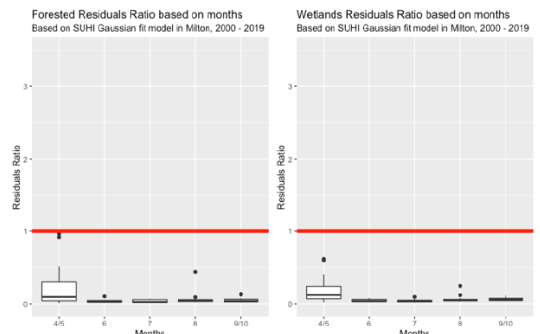
Figure 6 . The residuals ratio for forested and wetlands land covers determined by dividing the number of positive residuals by negative residuals within each captured Landsat 7 ETM+